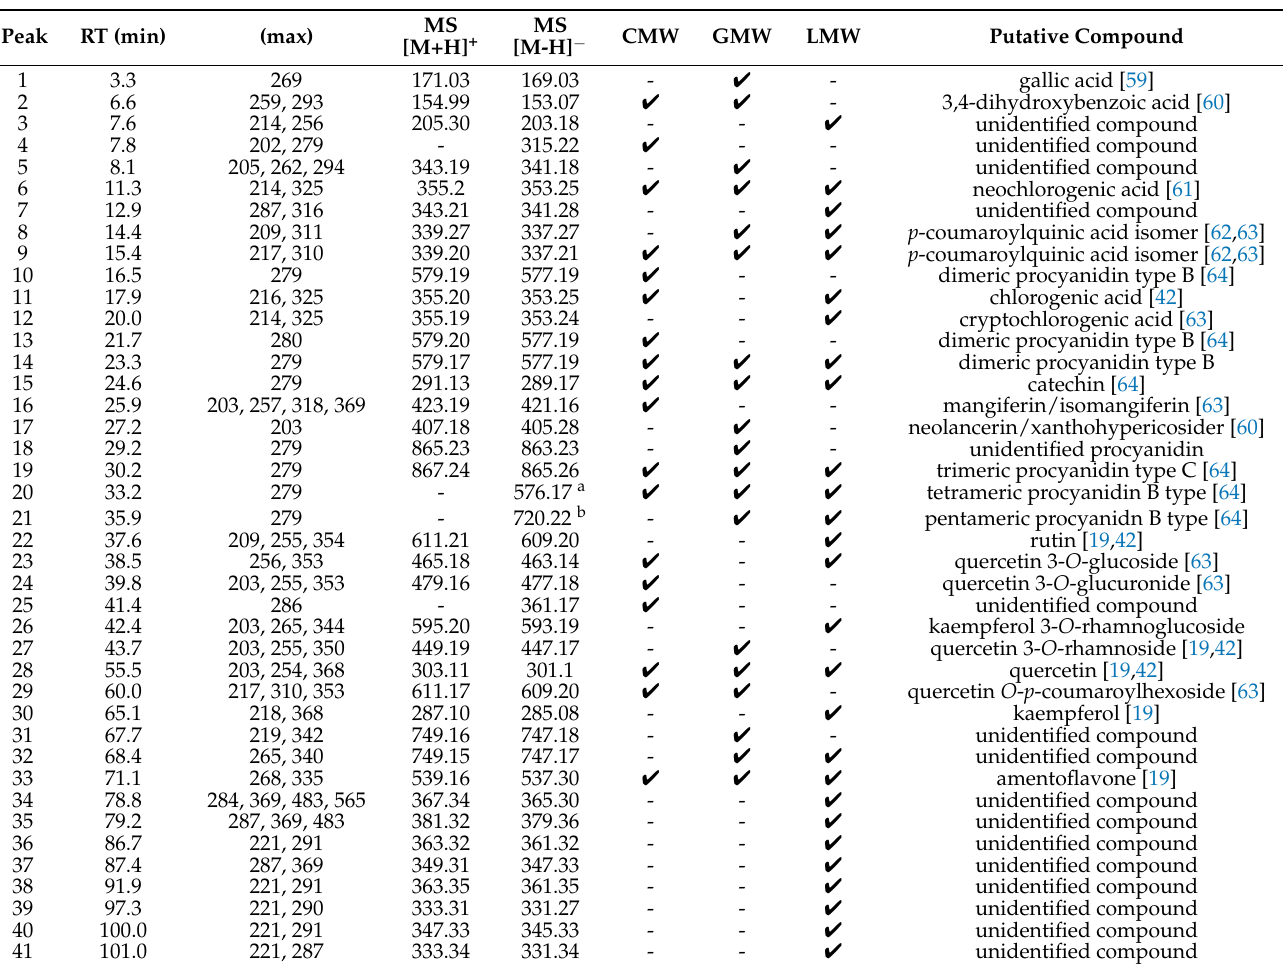
Table 2. Qualitative analysis of polar microextracts by liquid chromatography photodiode array detection mass spectrometry